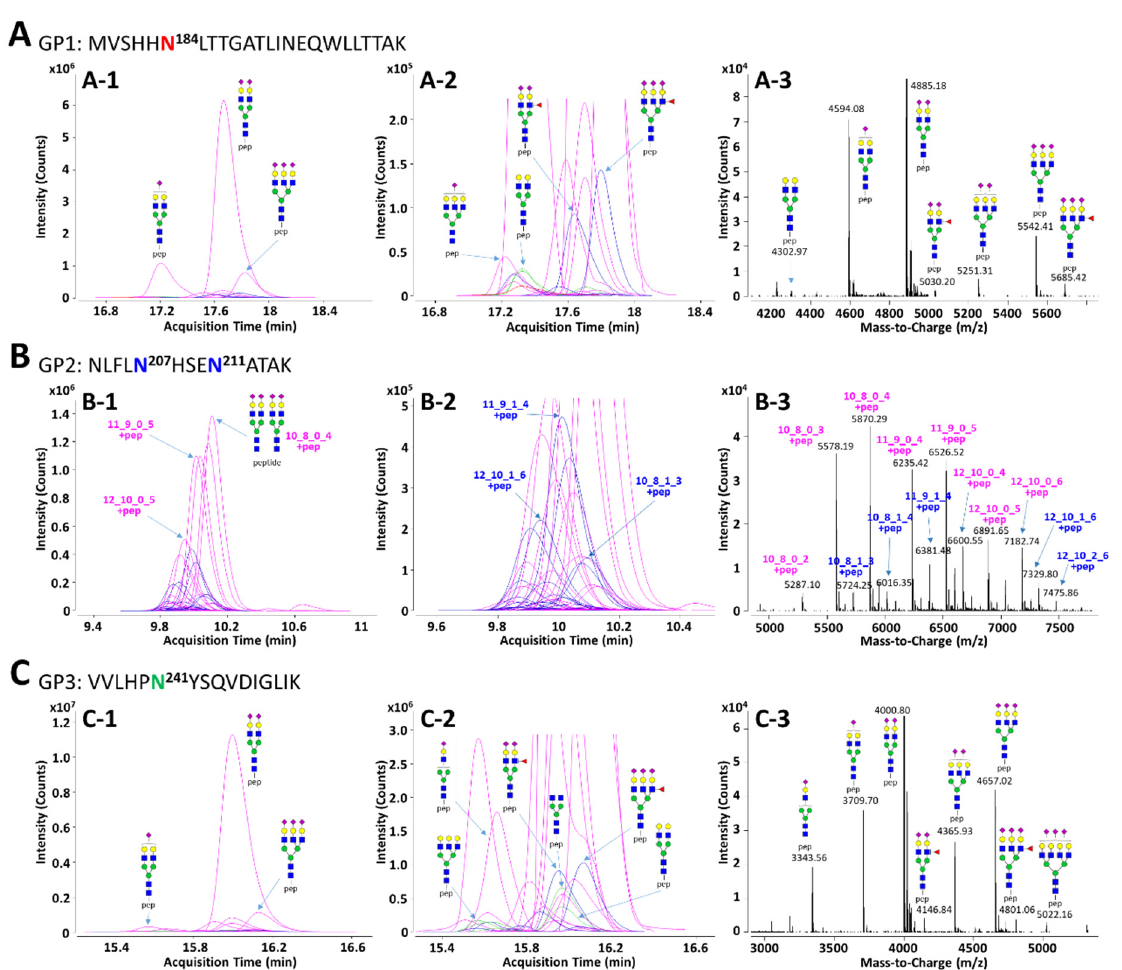
Figure 2. Representative extracted compound chromatograms (ECCs) and deconvoluted spectra of GP1 ( A ), GP2 ( B ), and GP3 ( C ) of haptoglobin purified from a commercial serum. The peptide sequence of each GP is inserted in the figure. The left column, ( A-1 ), ( B-1 ), and ( C-1 ), represents the ECCs of Hp glycopeptides identified using the in silico haptoglobin glycopeptide library. The middle column, ( A-2 ), ( B-2 ), and ( C-2 ), shows magnified views of low abundant glycopeptides on ECCs. The right column, ( A-3 ), ( B-3 ), and ( C-3 ), represents deconvoluted spectra of the retention time range that glycopeptides are eluted. Glycans on GP2 were represented by composition rather than structure since there are two glycosylation sites in one peptide. For feasible interpretation and visualization of low abundant glycans, the y -axes of GP1 and GP3 are displayed at about 3× magnification. Purple color—only sialylation; blue color—fucosylation and sialylation.